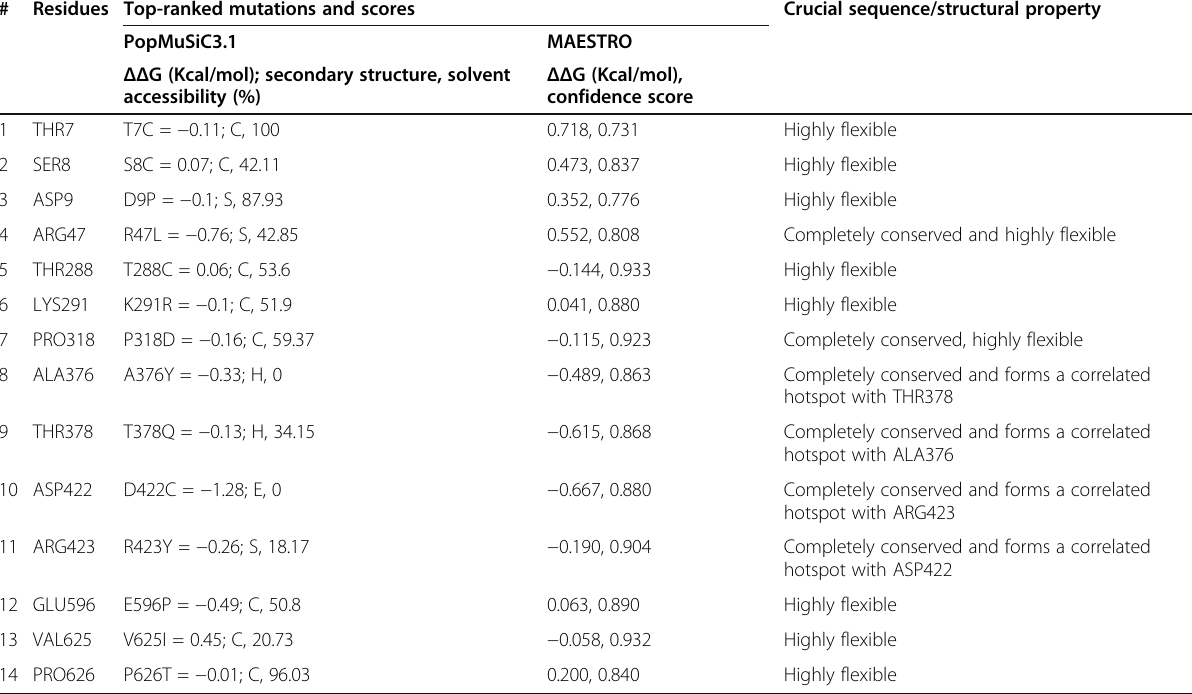
Table 2 List of predicted top-ranked mutations for the 14 hotspot residues # Residues Top-ranked mutations and